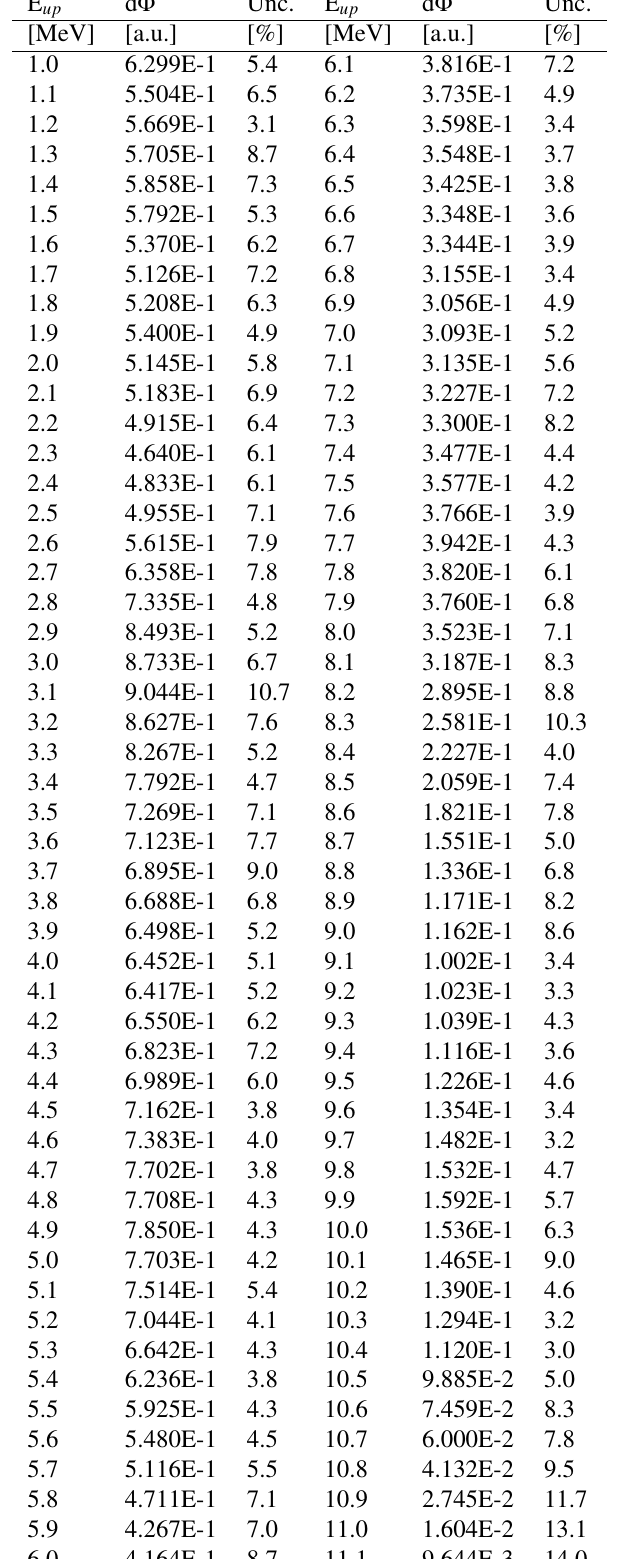
Table 1. Measured AmBe neutron leakage